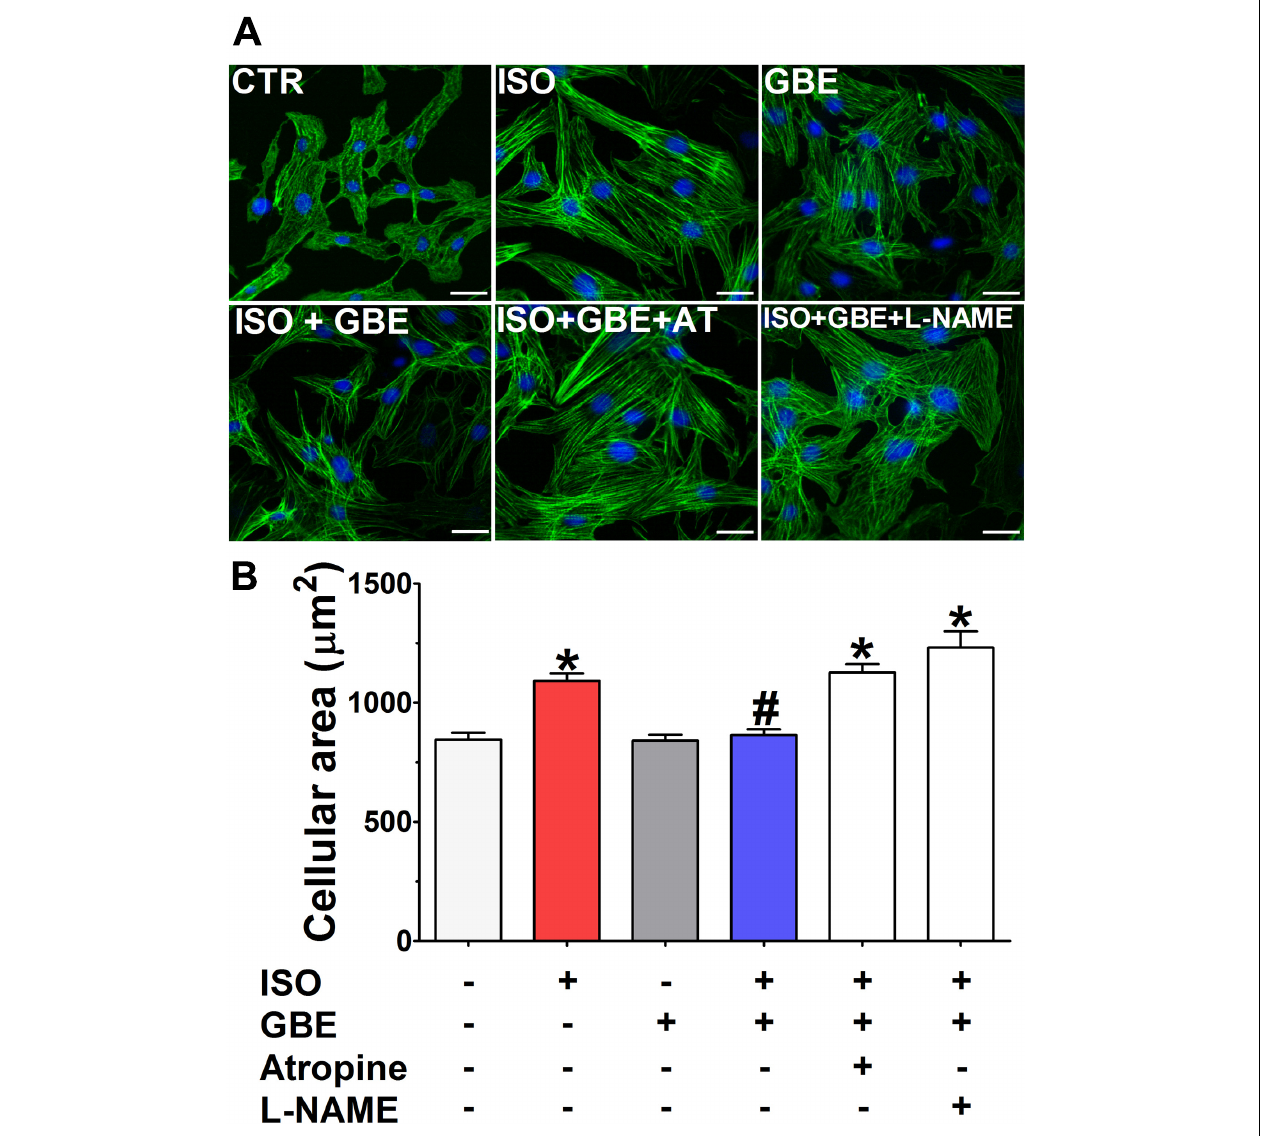
FIGURE 8 | Ginkgo biloba extract suppresses cellular hypertrophy induced by isoproterenol via M 2 /NO pathway in rat neonatal cardiomyocytes. (A) Representative immunofluorescence images from phalloidin/DAPI stained neonatal cardiomyocytes in control (CTR), Ginkgo biloba extract (GBE, 100 µ g/mL), isoproterenol (ISO, 10 µ M), isoproterenol plus Ginkgo biloba extract (ISO + GBE), isoproterenol plus Ginkgo biloba extract and muscarinic receptor antagonist, atropine (ISO + GBE + AT), isoproterenol plus Ginkgo biloba extract and nitric oxide synthase inhibitor, L-NAME (ISO + GBE + L-NAME) treated cells. (B) Quantification of cardiomyocyte surface area from experiments shown in (A) . Scale bar = 20 µ m. Data are represented as means ± SEM, ( n = 44–82 cells analyzed). ∗ p < 0.05 vs. CTR and # p < 0.05 vs. ISO, one-way ANOVA followed by Bonferroni’s